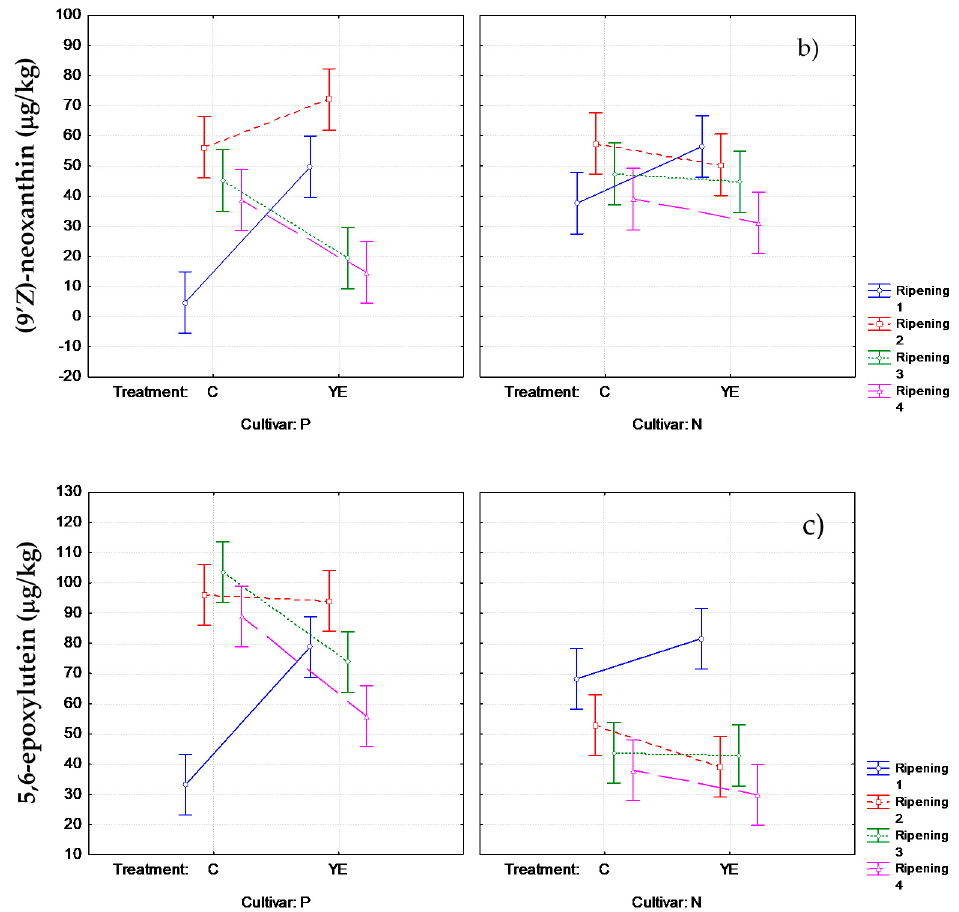
Figure 6. Violaxanthin ( a ), (9 ′ Z)-neoxanthin ( b ), and 5,6-epoxylutein ( c ) contents in yeast extract-treated (YE) and control (C) Negro Amaro and Primitivo wine grapes during ripening.